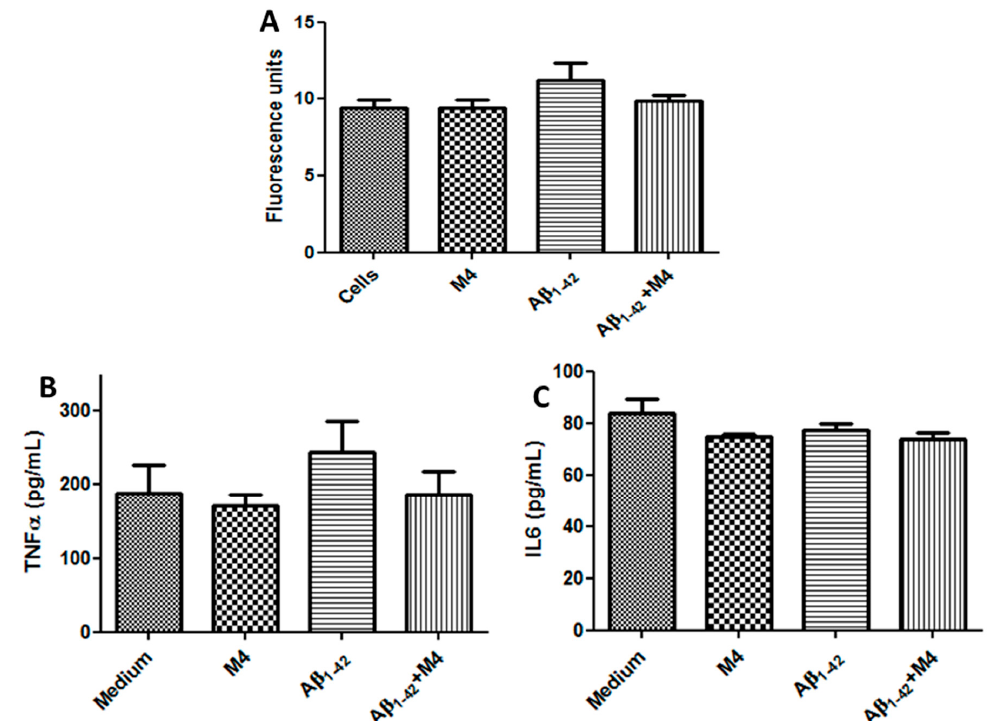
Figure 4. Changes in Reactive Oxigen Species (ROS) and pro-inflammatory cytokine levels in astrocytic primary cultures. ( A ) ROS determination by 2,7-Dichlorodihydrofluorescein Diacetate (DCFH-DA). The cells were treated with 100 µ M of M4 compound, 30 µ M of A β 1-42 , and 30 µ M of A β 1-42 + 100 µ M of M4 compound for 48 h, and after treated with DCFH-DA (20 µ M), the experiment was duplicated with n = 3. ( B ) TNF- α levels in the medium from astrocyte culture after 48 h of incubation with 100 µ M of M4 compound, 30 µ M of A β 1-42 , and 30 µ M of A β 1-42 + 100 µ M of M4 . ( C ) IL-6 levels in the medium from astrocyte culture after 48 h of incubation with 100 µ M of M4 compound, 30 µ M of A β 1-42 , and 30 µ M of A β 1-42 + 100 µ M of M4 . The results are presented as the mean ± SE. The experiment was duplicated with n = 2. Data were analyzed by one-way ANOVA followed by Tukey’s test